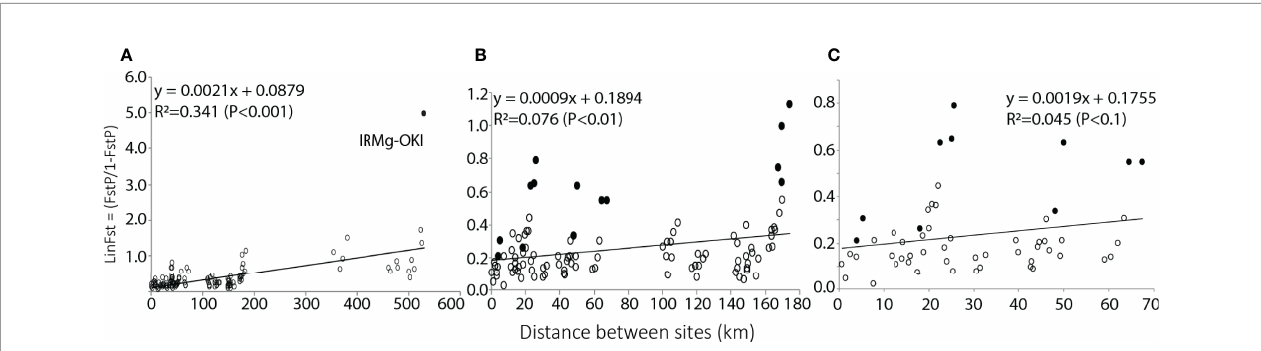
FIGURE 4 | The tendency of IBD (isolation by distance) became more apparent over the Sakishima region (B) and over the entire Ryukyu Archipelago (A) , which indicates decreasing gene fl ow affected by the absence of coastline over a certain distance. Within the Yaeyama region (C) , Euclidean and genetic distance did not show a correlation. All outliers in the plots are associated with IRMg indicating that the site is isolated by other environmental factors beside geographical distance or ocean connectivity. The Y-axis shows linearized genetic differentiation values, and the X-axis shows the Euclidean distance between paired sites. All fi lled markers in (B , C) are paired sites with